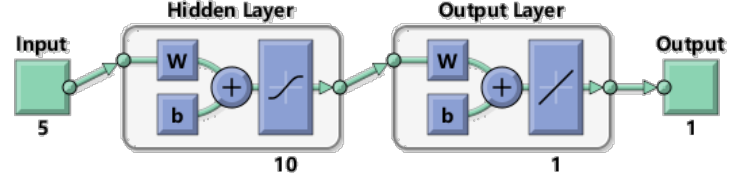
Figure 4. BP neural network structure diagram.